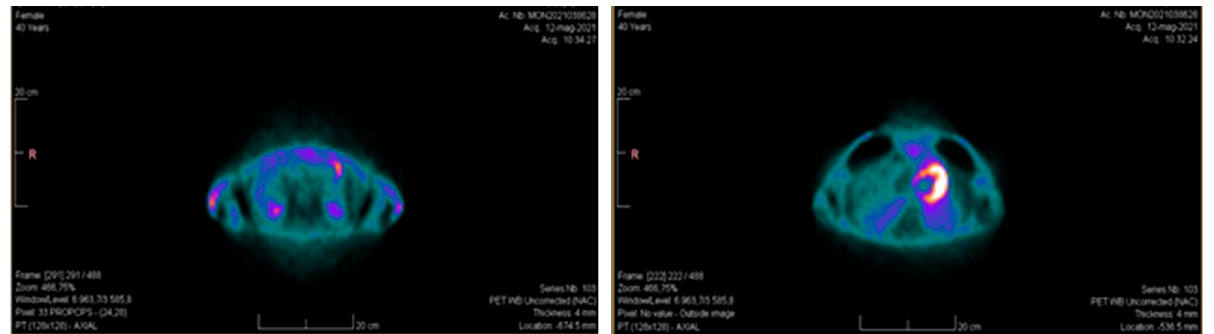
Figure 5. Whole-body positron emission tomography (PET) showing mildly increased 18-fluorodeoxyglucose uptake (18-FDG) in mediastinal lymph nodes (maximal standardized uptake value SUV 2.63), consistent with diffuse nonspecific inflammatory status.